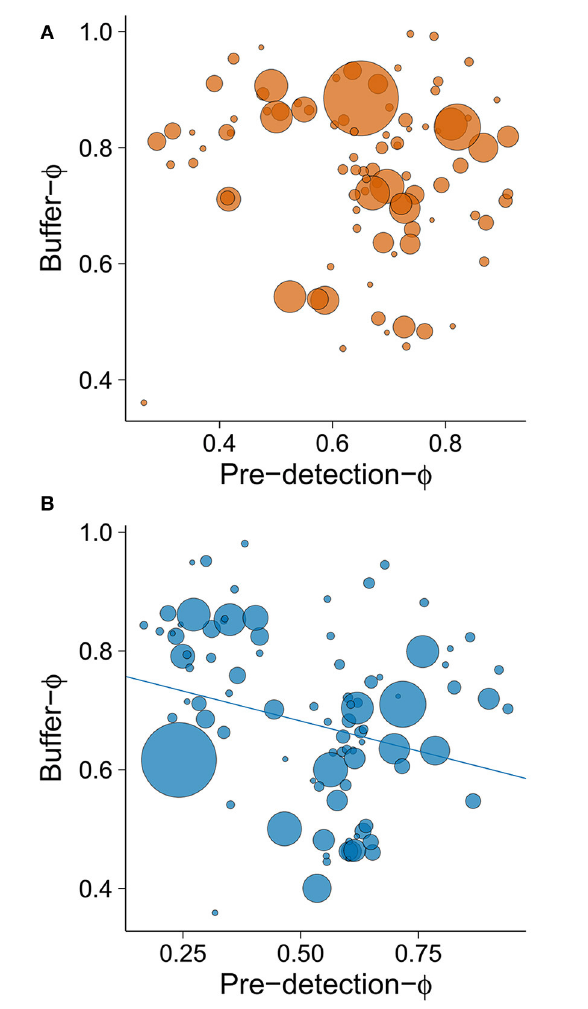
FIGURE 6 | The relationship between (A) latitude and rural-urban difference in buffer- 8 ( 1 buffer- 8 ) and (B) the relationship between latitude and buffer 8 by site. Lower values of buffer- 8 mean that birds tolerate more human approach after detection. Circle size in plot A is proportional to the sample size for a given population (min = 19, max = 358). In plot B, orange points and orange line represent rural populations whereas blue points and blue line represent urban populations. Circle size was fixed and points representing urban birds have been slightly displaced to right (0.7 degrees of latitude) to improve data visualization. Lines illustrate linear regressions.